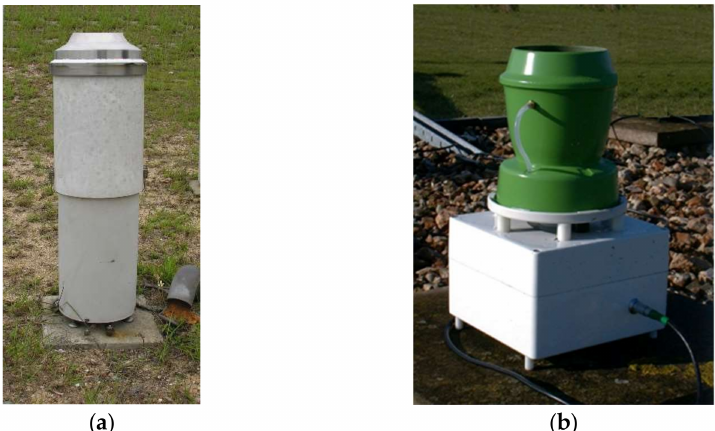
Figure 1. The Drop Counter rain gauges are manufactured by the Ogawa Seiki Co. Ltd. (OSC) ( a ) and the Chilbolton RAL (CRAL) ( b ).